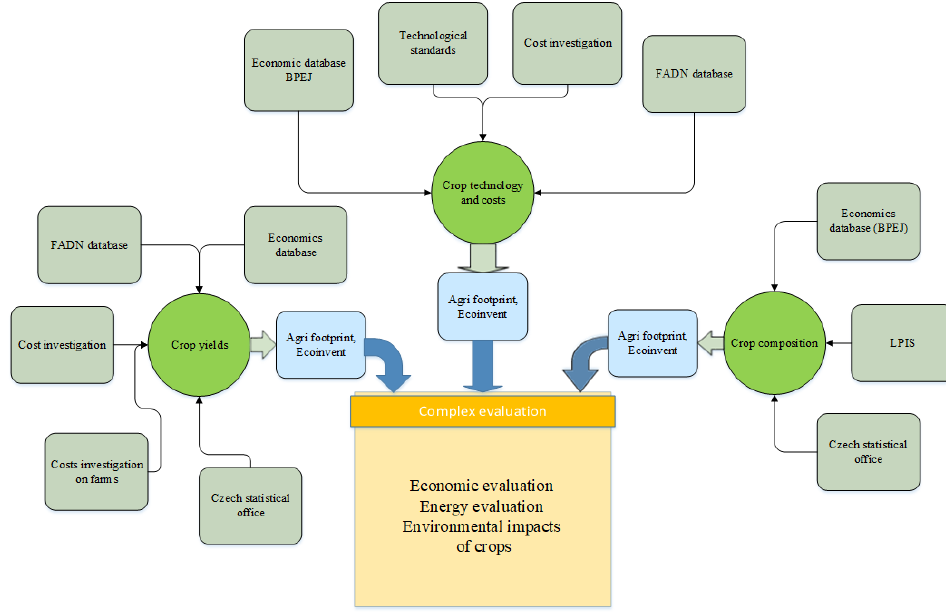
Figure 1. Processing of economic, energy and environmental data for calculation.